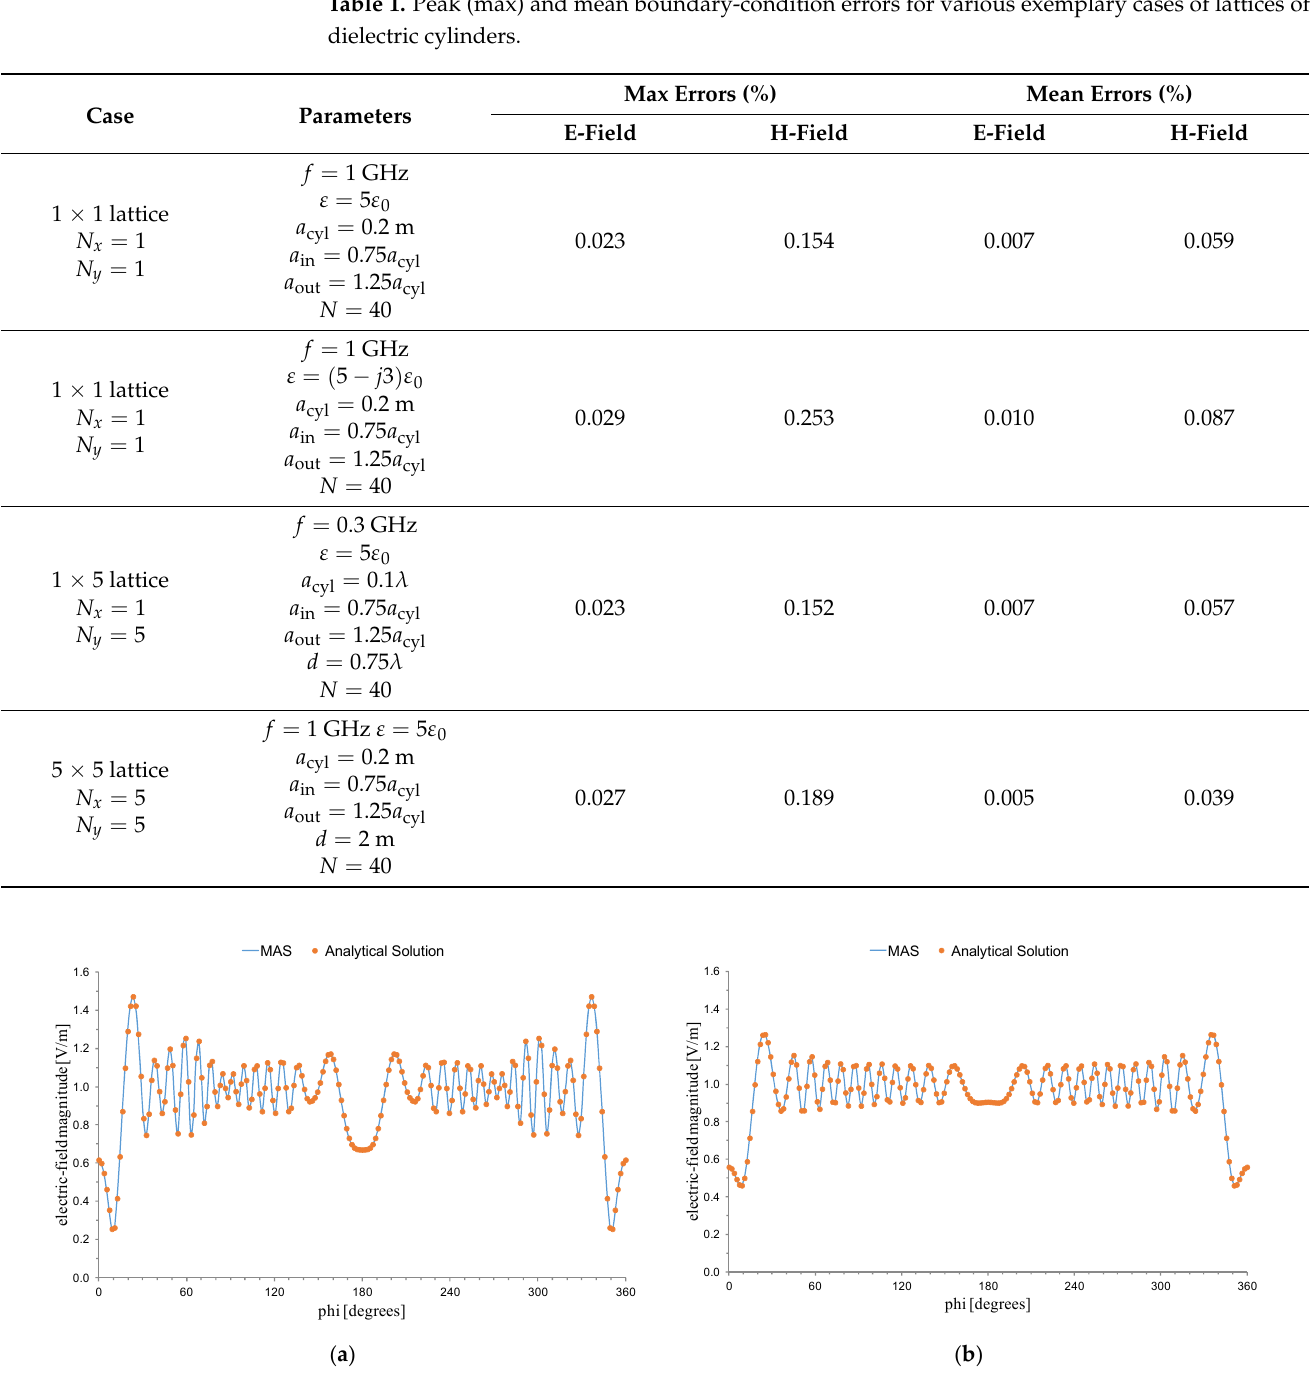
Figure 3. Electric-field magnitude, as a function of the observation angle in the azimuth plane, for an isolated dielectric cylinder (comprising a trivial lattice). The continuous lines correspond to the MAS results, whereas the dots show the results obtained from the respective analytical solutions. The parameters pertaining to the cylinder and the incident field are provided in Table 1. ( a ) corresponds to the lossless cylinder, whereas ( b )corresponds to the lossy